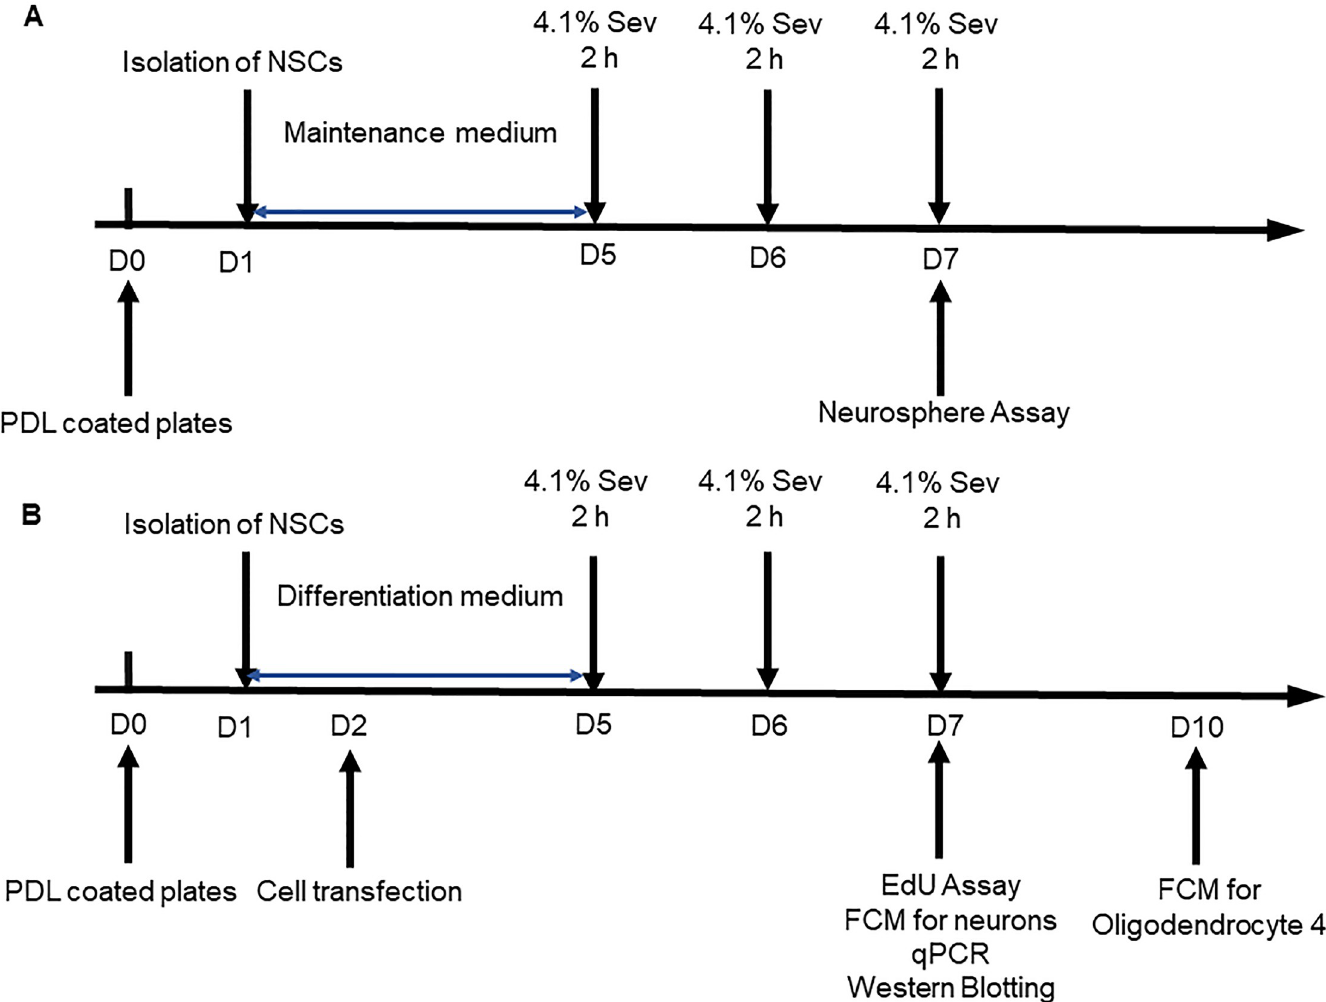
Fig 1. Diagrams for the experimental design. A. NSCs were cultured in DMEM-F12 (1:1) maintenance medium containing 20 ng/mL of hEGF, bFGF, 1% N2 and 2% B27 for four days. The NSCs were exposed to sevoflurane (4.1% sevoflurane in 60% O 2 ) or control 60% O 2 alone 2 h daily for three consecutive days. The self-renewal of NSCs was analyzed by neurosphere formation. B. The NSCs (6 x 10 5 cells/well) were cultured onto coverslips that had been coated with poly-l-lysine/laminin in DMEM-F12 (1:1) differentiation medium containing half concentration of growth factors to induce their differentiation for four days. The NSCs were exposed to sevoflurane (4.1% sevoflurane in 60% O 2 ) or control 60% O 2 alone 2 h daily for three consecutive days. The differential neurons and oligodendrocytes and astrocytes were characterized at day 7 and 10 post induction, respectively.